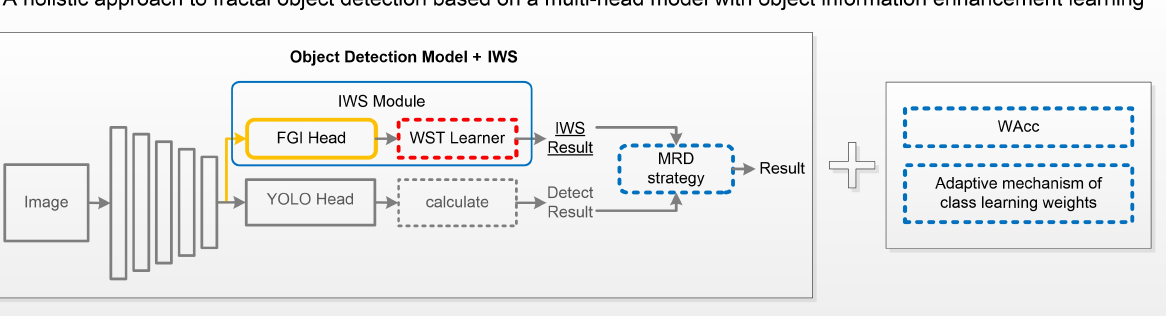
Figure 3. A holistic approach to fractal object detection based on a multi-head model with object information enhancement learning.